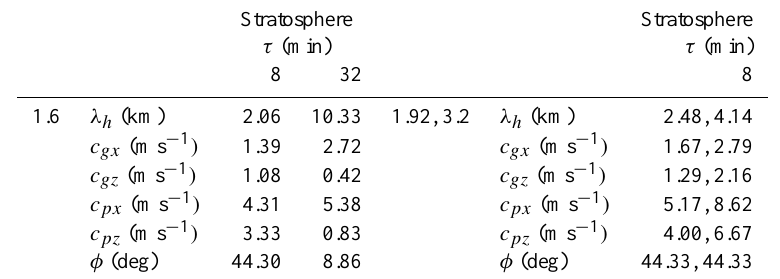
Table 2b. Same as Table 2a in the